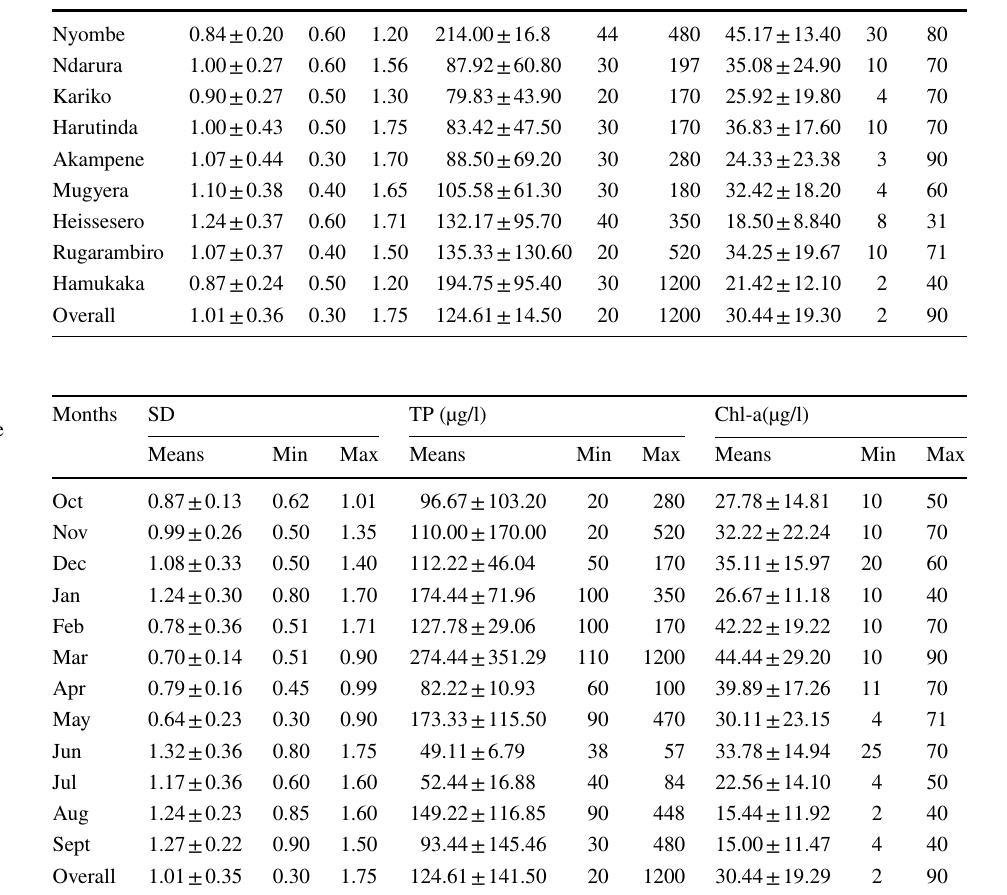
Table 2 Mean ± Std. Dev. of trophic state indicator variables at different sampling points ( n = 108)